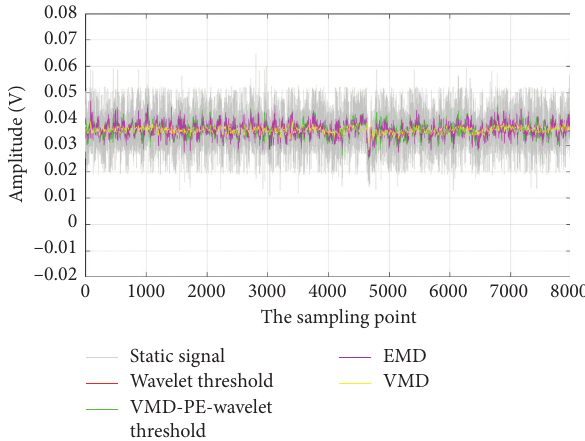
Figure 11: Static signal denoising results.